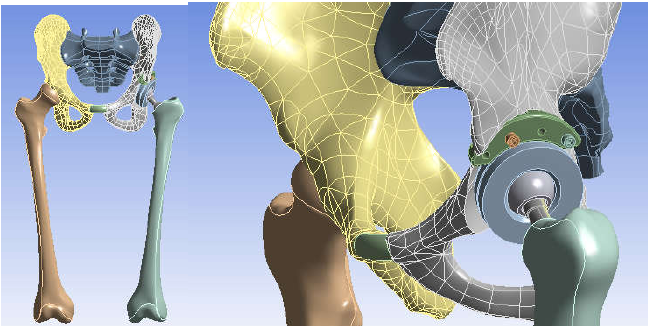
Figure 39. Analysed orthopaedic model loaded in Ansys. The division into finite elements and the finite element structure of the orthopaedic system.